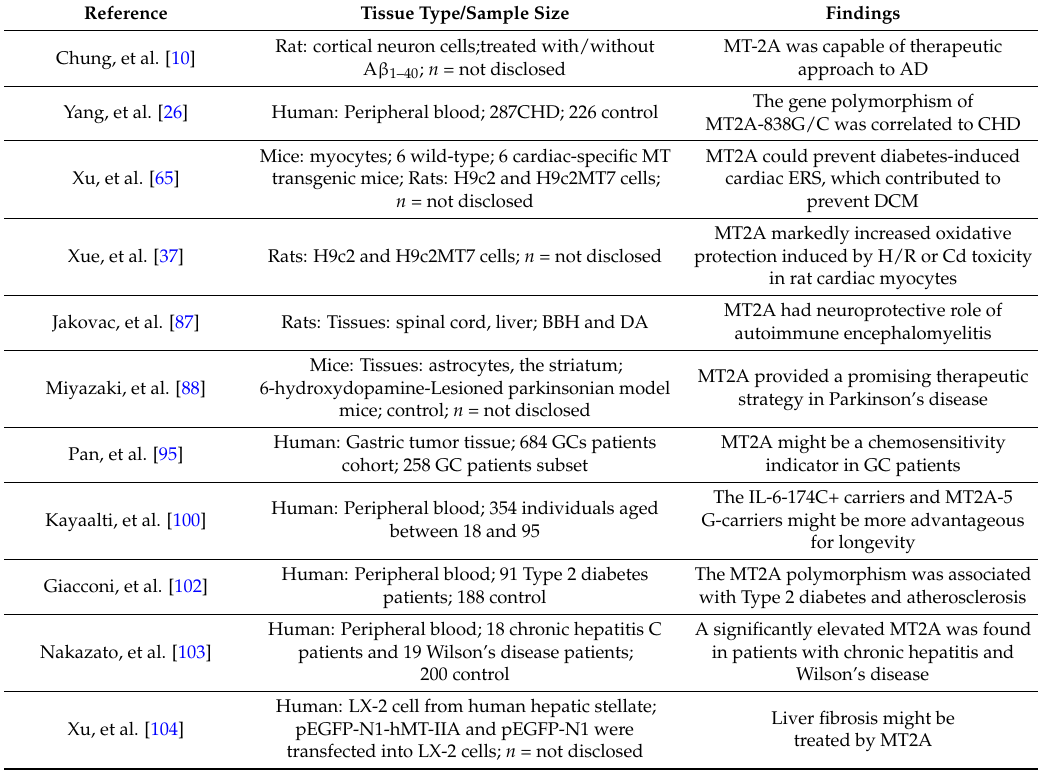
Table 1. Summary of MT2A in relation to